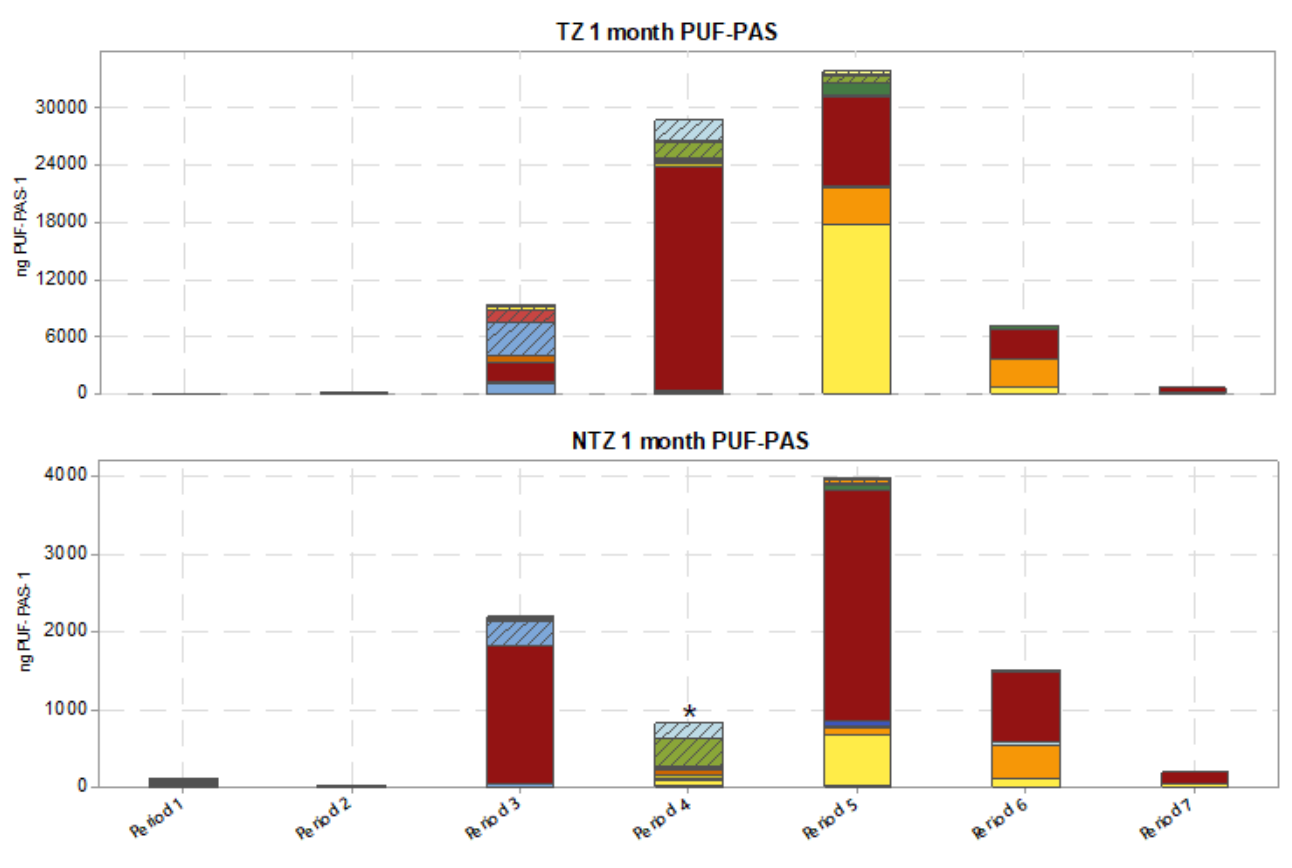
Figure 3. Monthly cumulative amounts (ng PUF-PAS − 1 ) found in the treated (TZ) and nontreated (NTZ) zones by PUF-PAS in 2013 and correspondence periods (period 1: 20 February–21 March, (NTZ) zones by PUF-PAS in 2013 and correspondence periods (period 1 : 20 February-21 March, period 2: 21 March–23 April, period 3: 23 April–29 May, period 4: 29 May–26 June, period 5: 26 June– period 2 : 21 March-23 April, period 3 : 23 April-29 May, period 4 : 29 May-26 June, period 5 : 26 June-24 July, period 6 : 24 July-11 September, period 7 : 11 September-17 October) . * Folpet and some 24 July, period 6: 24 July–11 September, period 7: 11 September–17 October). * Folpet and some other other CUPs not analyzed (see Table S6). CUPs not analyzed (see Table